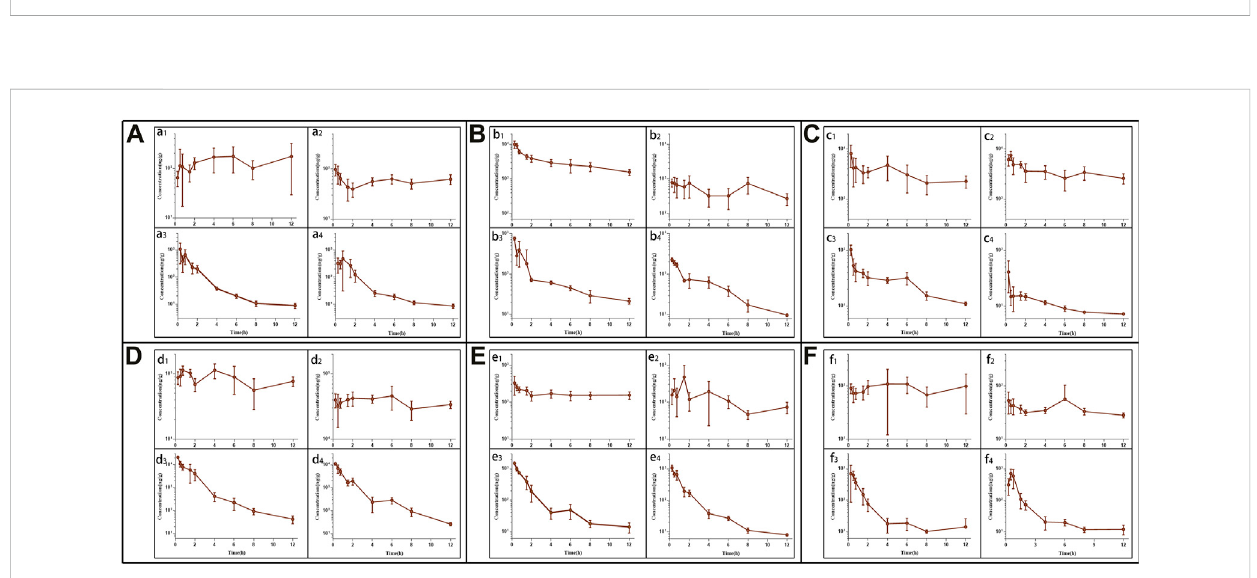
FIGURE 5 The tissue pharmacokinetic curves of evodiamine (EDM) and dehydroevodiamine (DEDM). The EDM (5, 2.5 mg/kg) and DEDM (10, 5 mg/kg) was injected through tail vein. After blood was collected at 0.25, 0.5, 1, 2, 3, 4, 6, 8 and 12 h after dose (with 7 mice at each time point), the mice were rapidly dissected.Theheartwasperfusedwithsalineuntiltheliverbecamewhite.Next,theheart,liver,spleen,lung,kidney,andbrainwereexcised,weighedand homogenised. The tissue samples were analysed by HPLC-MS/MS and draw pharmacokinetic curves. (A) Heart; (B) Liver; (C) Spleen; (D) Lung; (E) Kindy; (F)